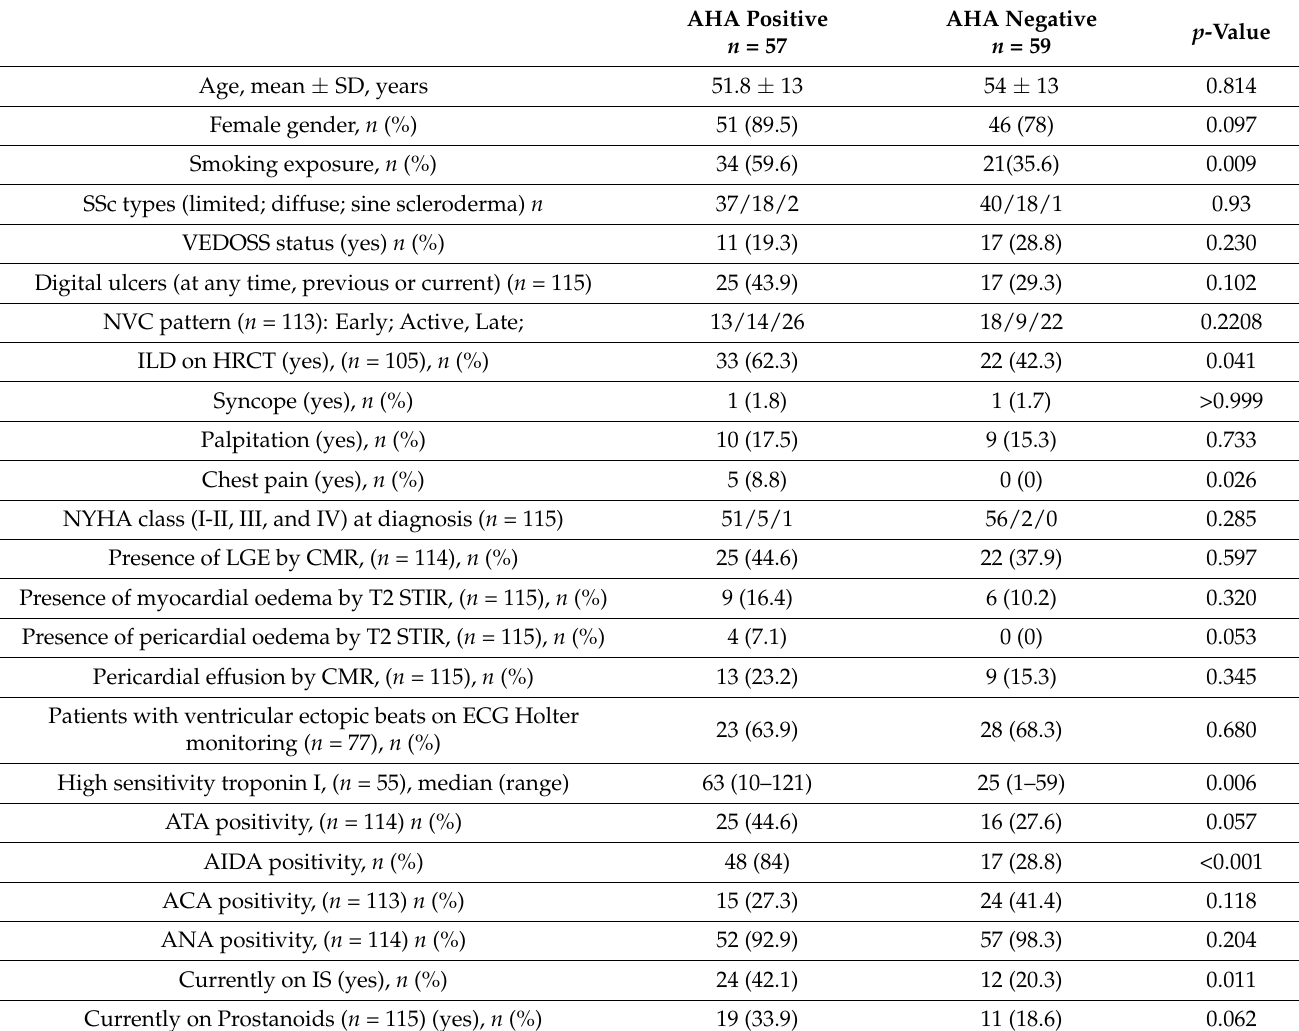
Table 2. Demographic, clinical, imaging, and immunological characteristics of patients according to AHA positivity.